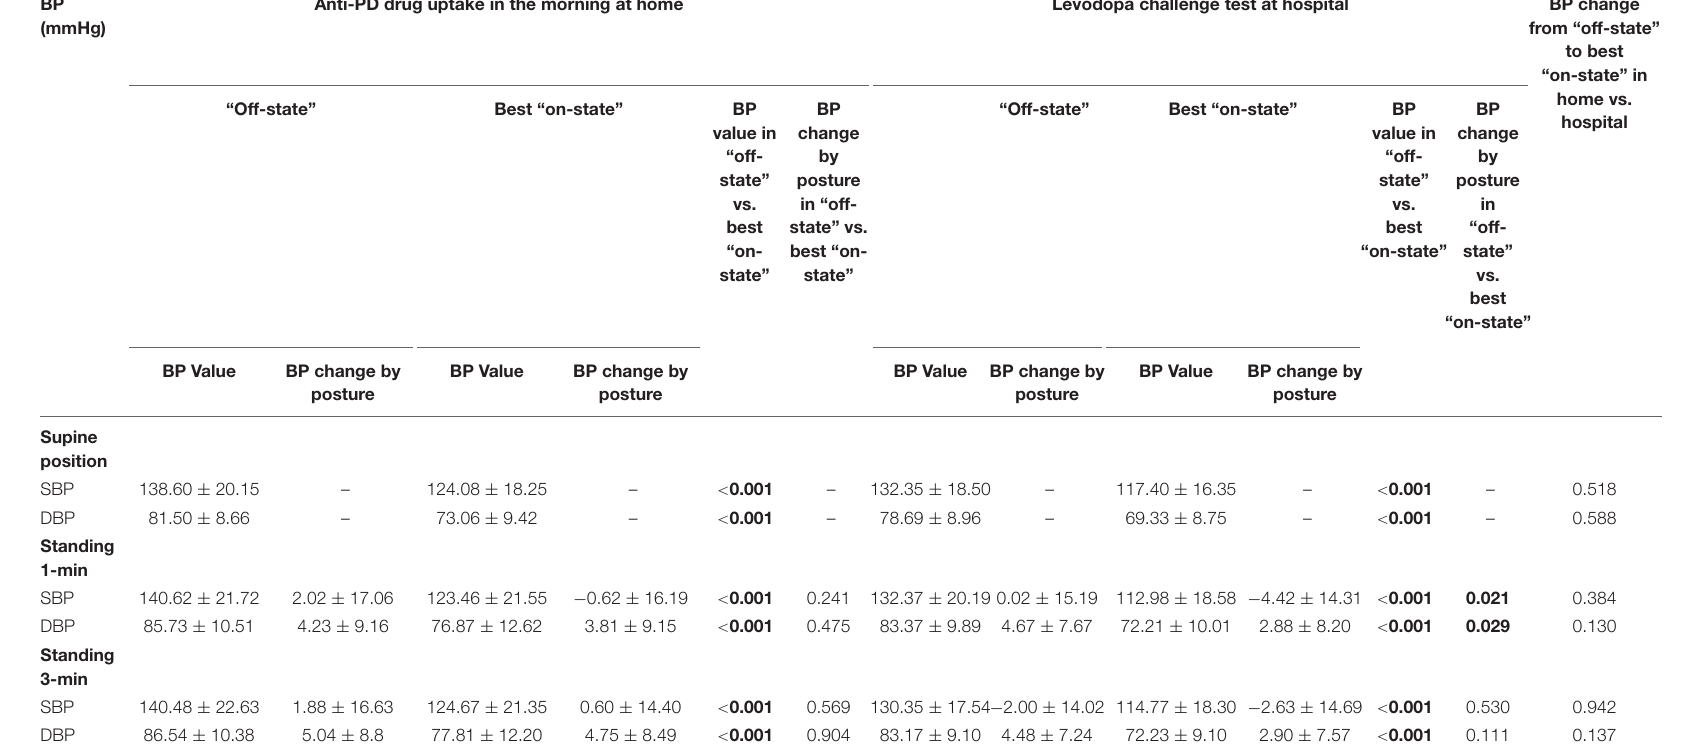
Data were shown as mean ± SD. Difference between subgroups were performed using paired comparison by Wilcoxon test. BP change by posture was defined as BP change after orthostatism in the standardized standing test; BP value in “off-state” vs. best “on-state” was defined as the comparisons of absolute BP in corresponding position in the “off-state” and that in the best “on-state” (both at home and hospital); BP difference by posture in “off- state” vs. best “on-state” was defined as comparisons of BP change after orthostatism between “off-state” and best “on-state” (both at home and hospital); Difference of BP change from “off-state” to best “on-state” in home vs. hospital was defined as the comparisons of absolute BP change from “off-state” to best “on-state” between home and hospital; P-values with statistic significance ( < 0.05) are in bold. PD, Parkinson’s disease; BP, blood pressure; SBP, systolic blood pressure; DBP, diastolic blood pressure; “off-state,” defined as the period when all anti-PD drugs were withdrawn for at least 12 h; best “on-state,” defined as the peak of anti-PD drugs benefit in the morning at home or the peak of levodopa benefit in the levodopa challenge test at